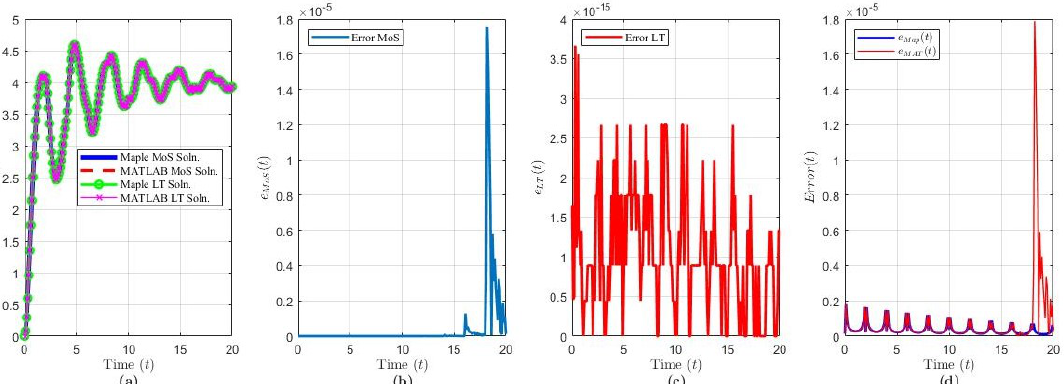
Figure 6. Solution results of Equation (23) over t ∈ [ 0,10 τ ] ( n = 500 terms): plot of ( a ) the solution y ( t ) via each method and software, ( b ) e MoS ( t ) , ( c ) e LT ( t ) , ( d ) e Map ( t ) and e MAT ( t )